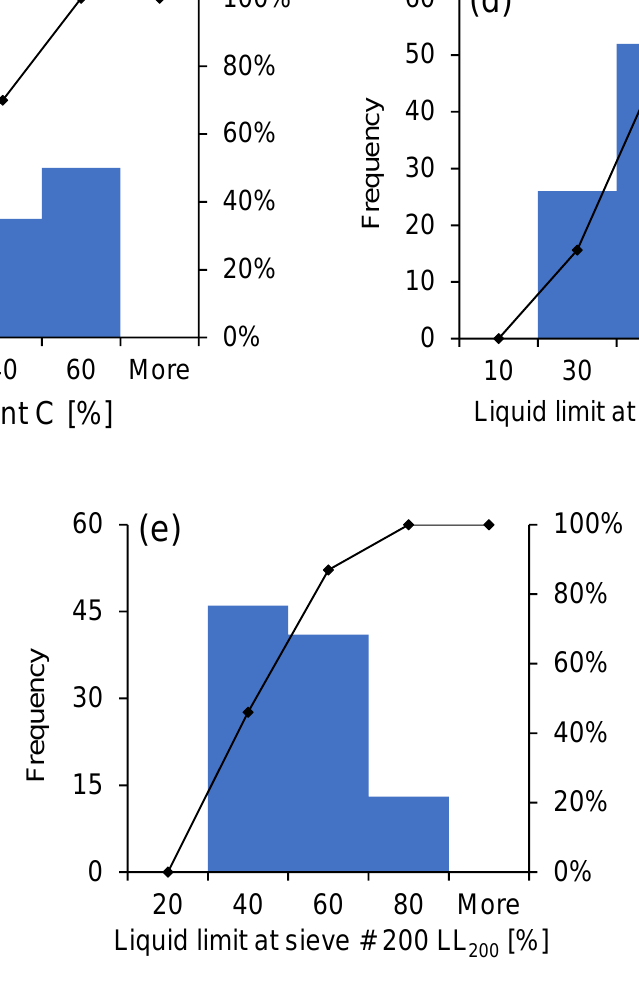
Figure 3. Frequency distribution histograms of experimental data: ( a ) sand content S [%]; ( b ) silt content M [%]; ( c ) clay content C [%]; ( d ) liquid limit from # 40 sieve passing material LL 40 [%]; ( e ) liquid limit from # 200 sieve passing material LL 200 [%]. Table 1. Statistics of input and output data for LL 200 prediction model.